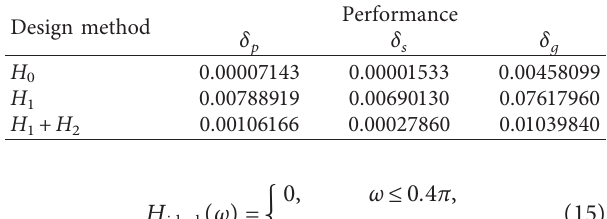
Table 2: Performance comparison in example 2. Design